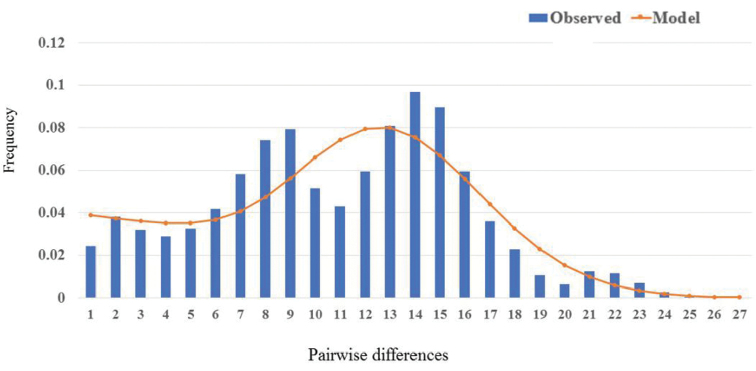
The observed pairwise difference (bars) and the expected mismatch distributions under the sudden-expansion model (solid line) of mtDNA control region haplotypes in S.marmoratus.